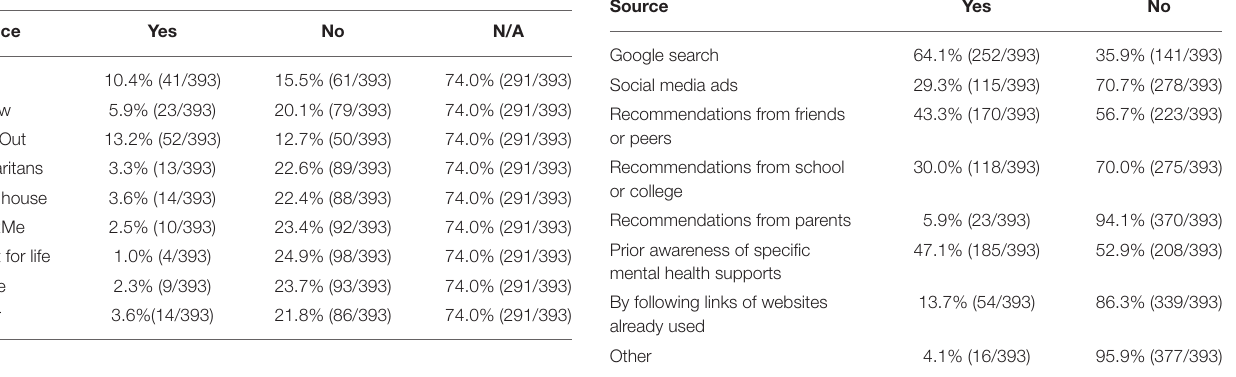
TABLE 2 | Use of health or charity services.